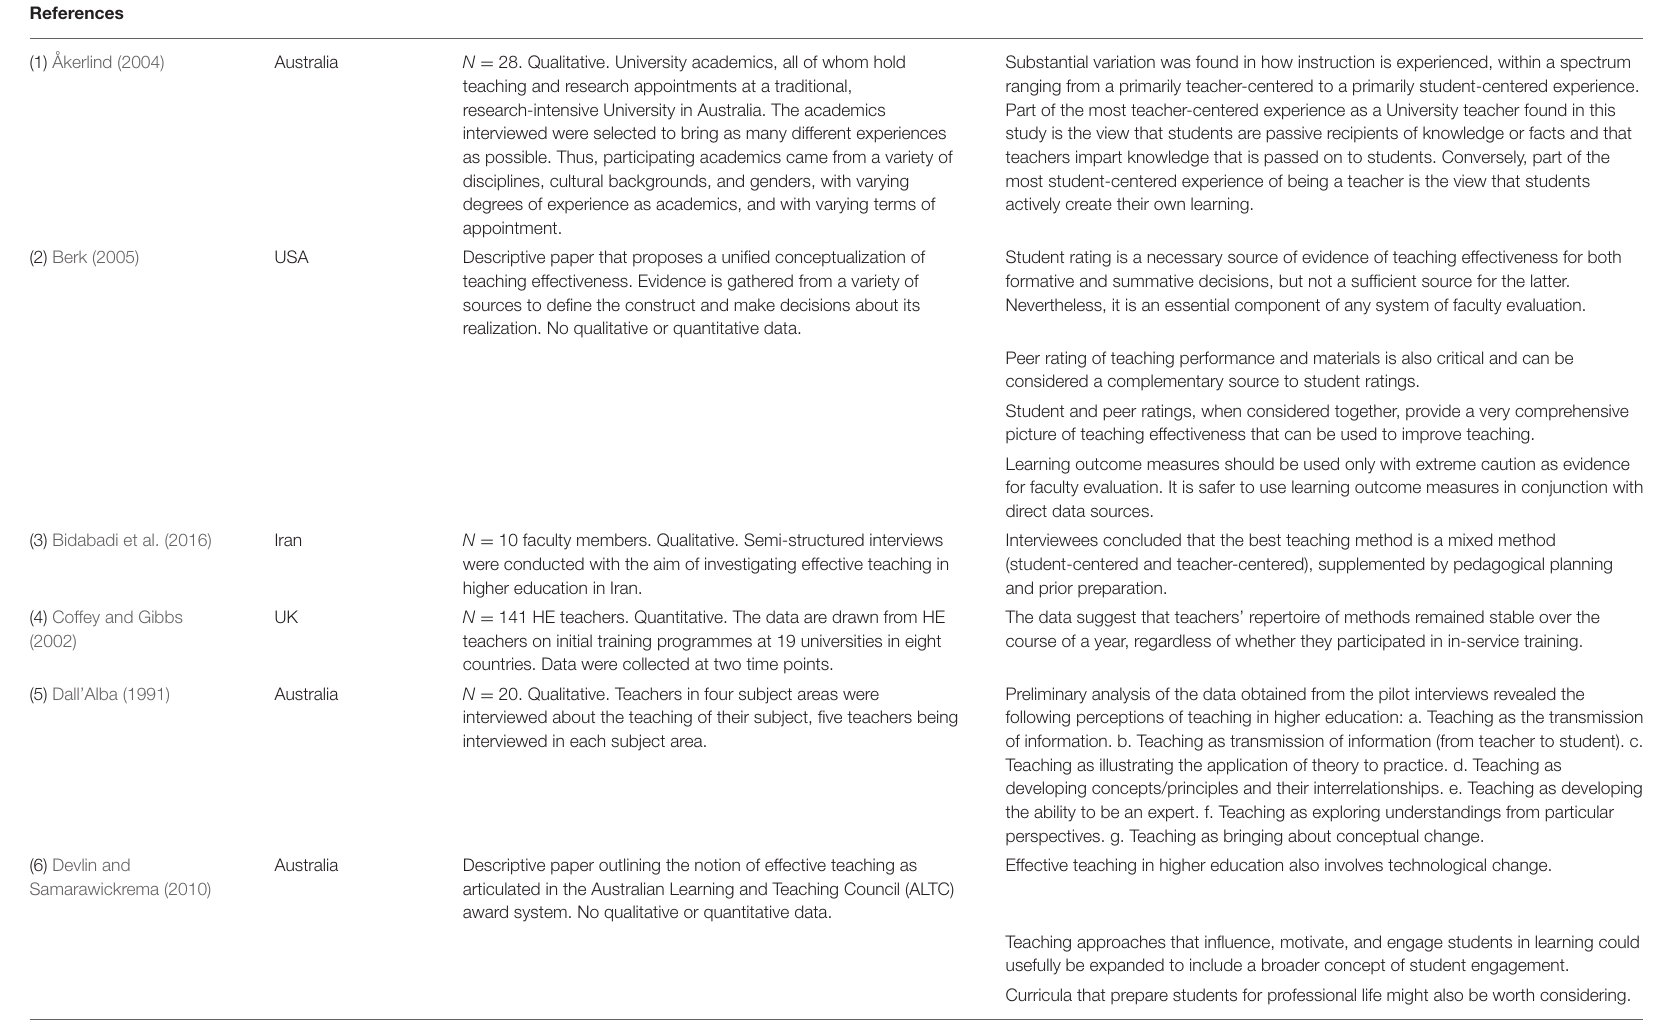
TABLE 3 | Included studies from 1990 (in alphabetical